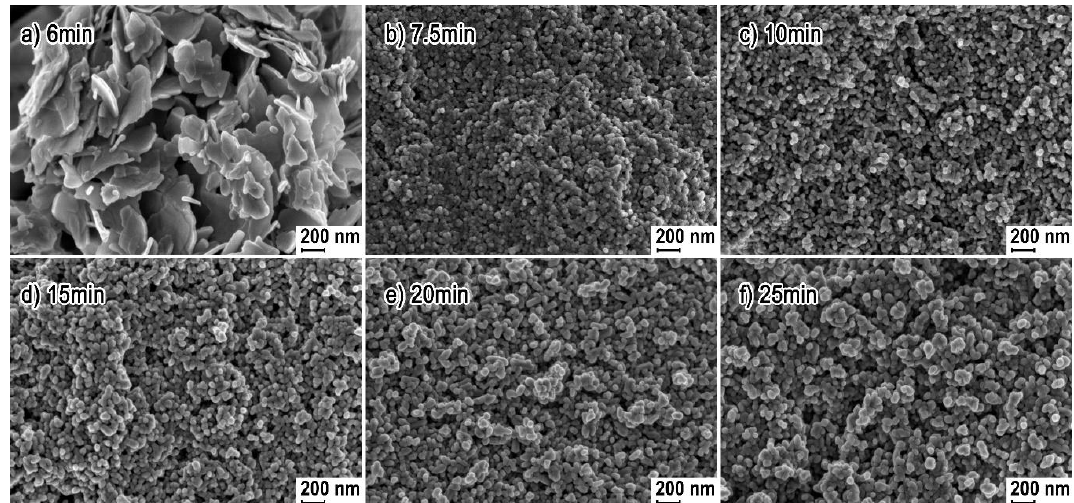
Figure 50. SEM images of ZnO NPs synthesis products obtained from the 4% H 2 O precursor, for synthesis durations of ( a ) 6 min; ( b ) 7.5 min; ( c ) 10 min; ( d ) 15 min; ( e ) 20 min; ( f ) 25 min, respectively. Republished with permission of © IOP Publishing Ltd from [402], Copyright